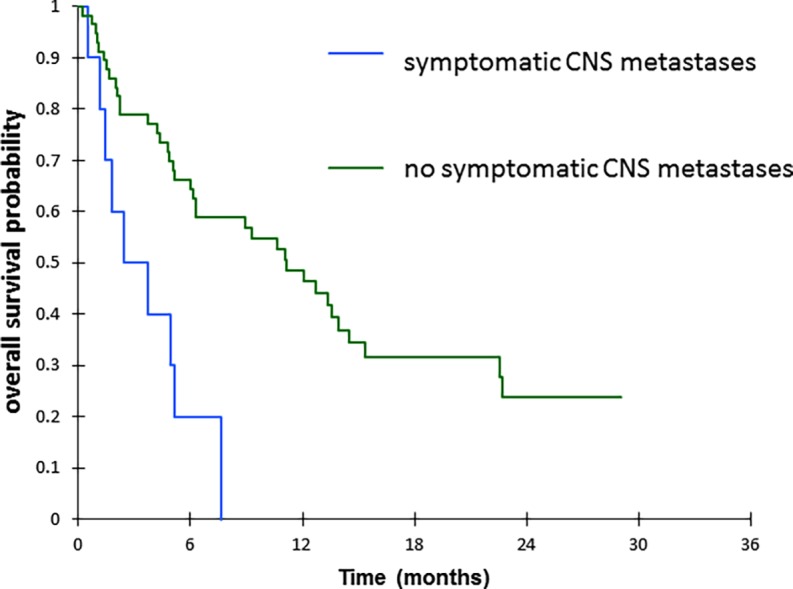
Overall survival according to the presence/absence of symptomatic central nervous system (CNS) metastases.p = 0.001 (log-rank test).